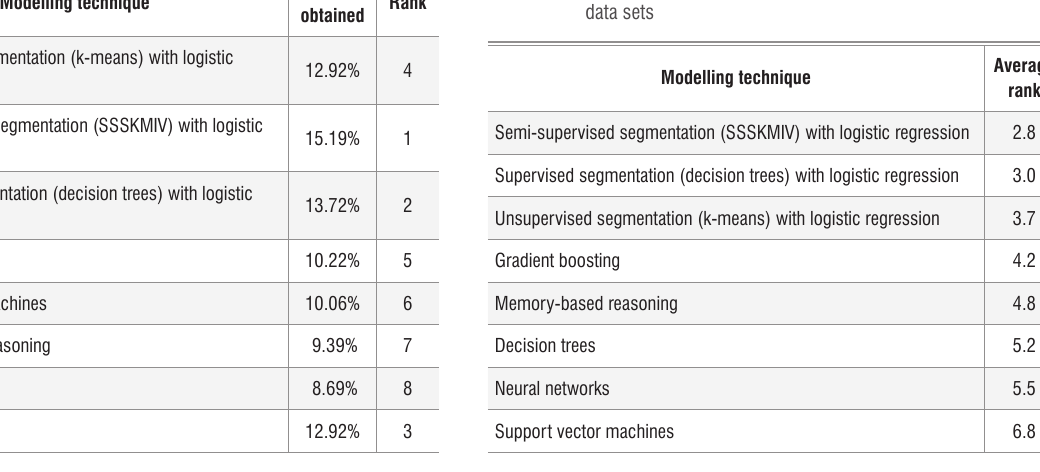
Average ranking position of modelling techniques over all six data sets Modelling technique